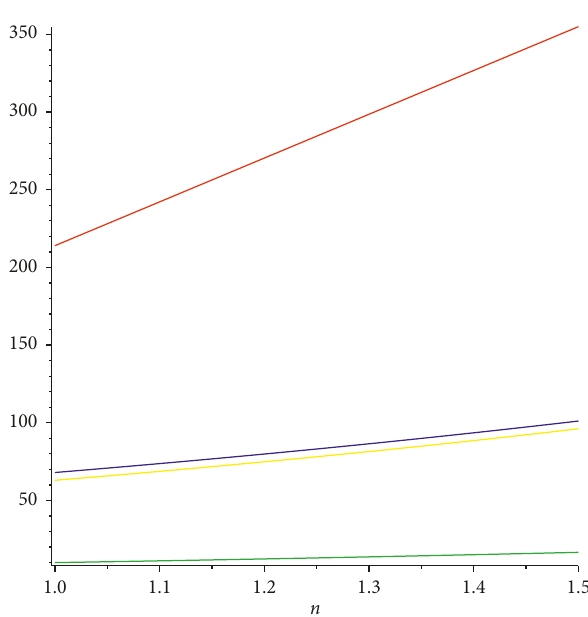
P n n , PETI, DPZ n , and